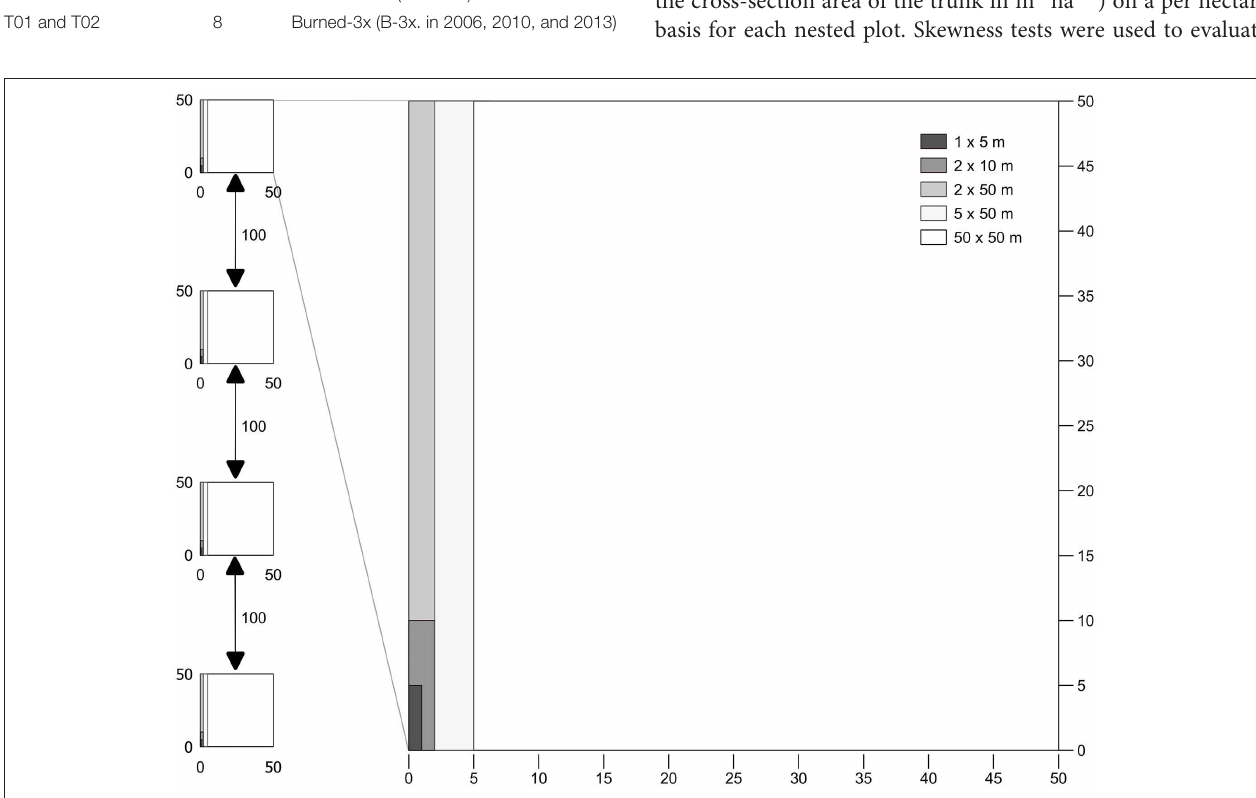
FIGURE 2 | Sampling plot and nested subplot distribution. Each transect consisted of four 50 × 50m plots composed of five subplots corresponding to the separate strata: 1 × 5m, Seedling (SE); 2 × 10m, Saplings (SP); 2 × 50m, Small Trees and Lianas (SML); 5 × 50m, Medium Trees (MT); 50 × 50m, Large Trees (LT).